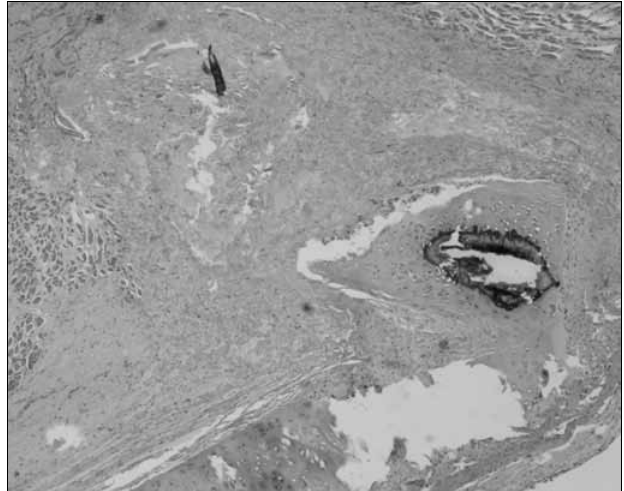
Figure 2. Hematoxylin-eosin. 40X - right vocal fold. Fascia graft in the vocal muscle of a rabbit euthanized after 60 days. Note mild scarring in the vocal muscle. The implanted fascia may be seen.